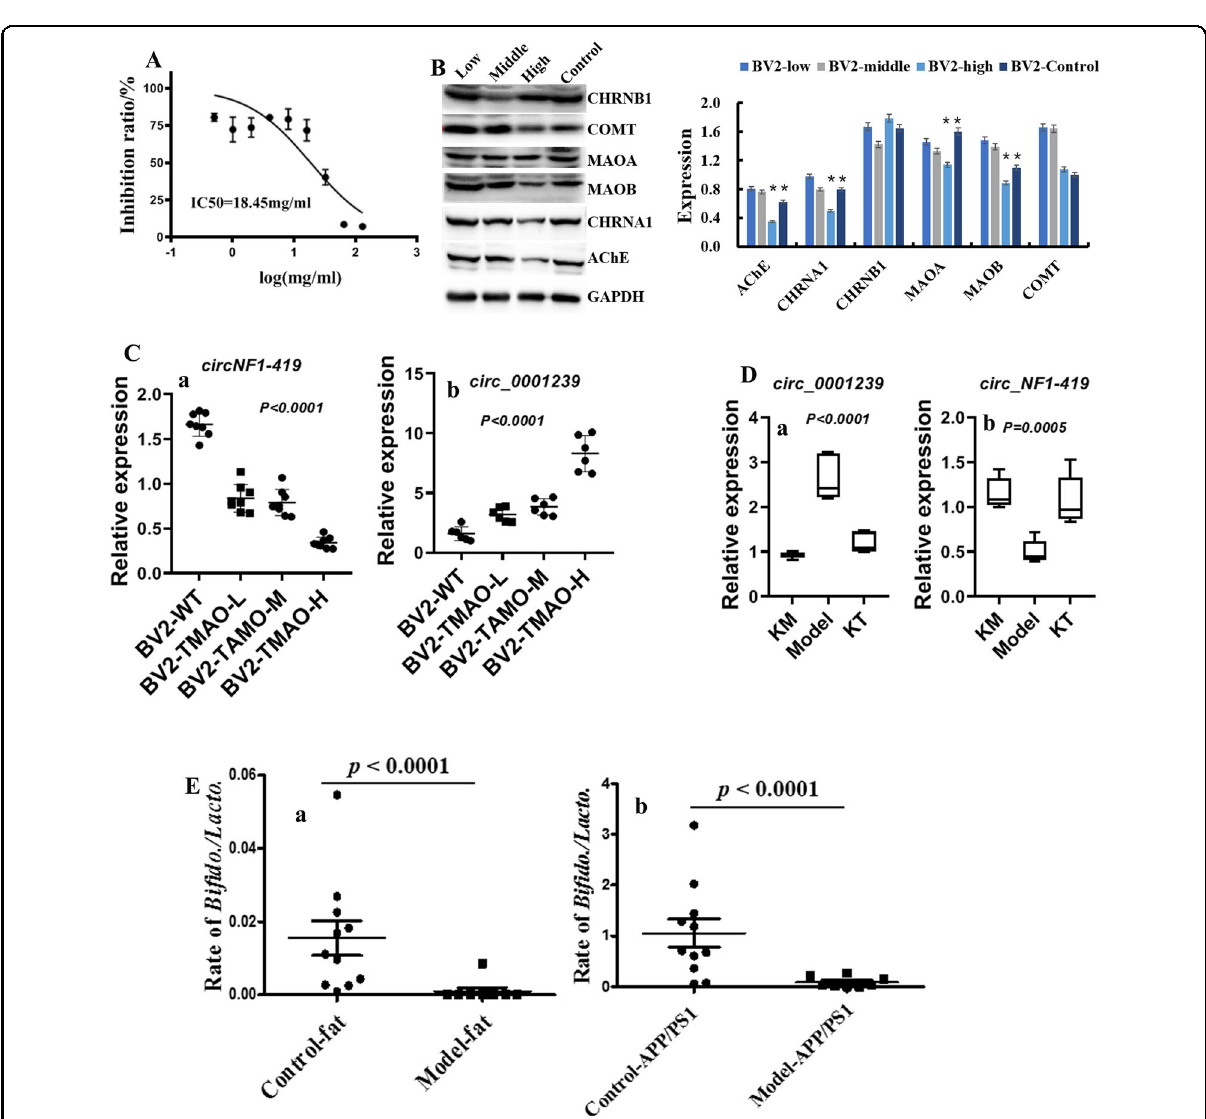
Fig. 6 Effects of TMAO on BV2 cells. A Effects of TMAO on proliferation of BV2 cells, measured using the MTT assay. B Expression of MAOA, MAOB, COMT, AChE, AMP, CHRNA1, and CHRNB1 in TMAO- damaged BV2 cells. C Expression of circNF1-419 and circ_0001239 in TMAO- damaged BV2 cells. D Expression of circNF1-419 and circ_0001239 in Kombucha tea- treated mice. E Ratio of abundance of Bi fi dobacterium species and Lactobacillus species was imbalanced in mice fed a HSHF diet and in AD-like mice. Data are the mean ± SD of more than fi ve independent experiments (and three independent experiments when using western blotting). * p < 0.05 and ** p < 0.01 vs. the model group by one-way ANOVA, followed by the Holm – Sidak